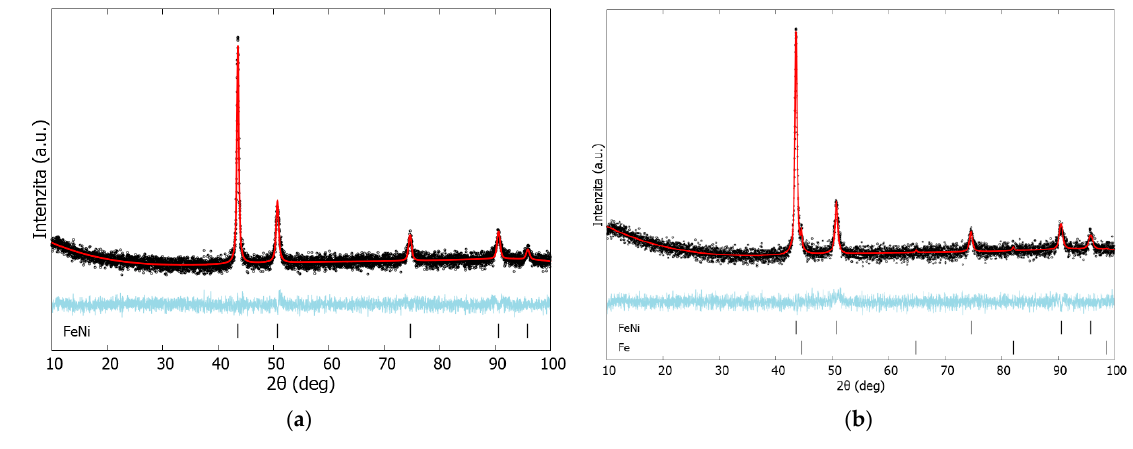
Figure 11. Diffraction spectrum: E Ni 6625 ( a ), E 18 8 Mn B 2 2 ( b ). Table 6. Parameters from refining di ff raction